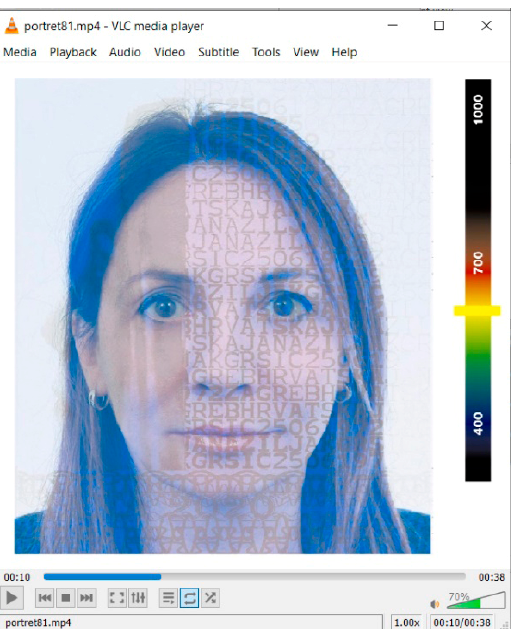
Figure 16. Blockage at 600 nm.